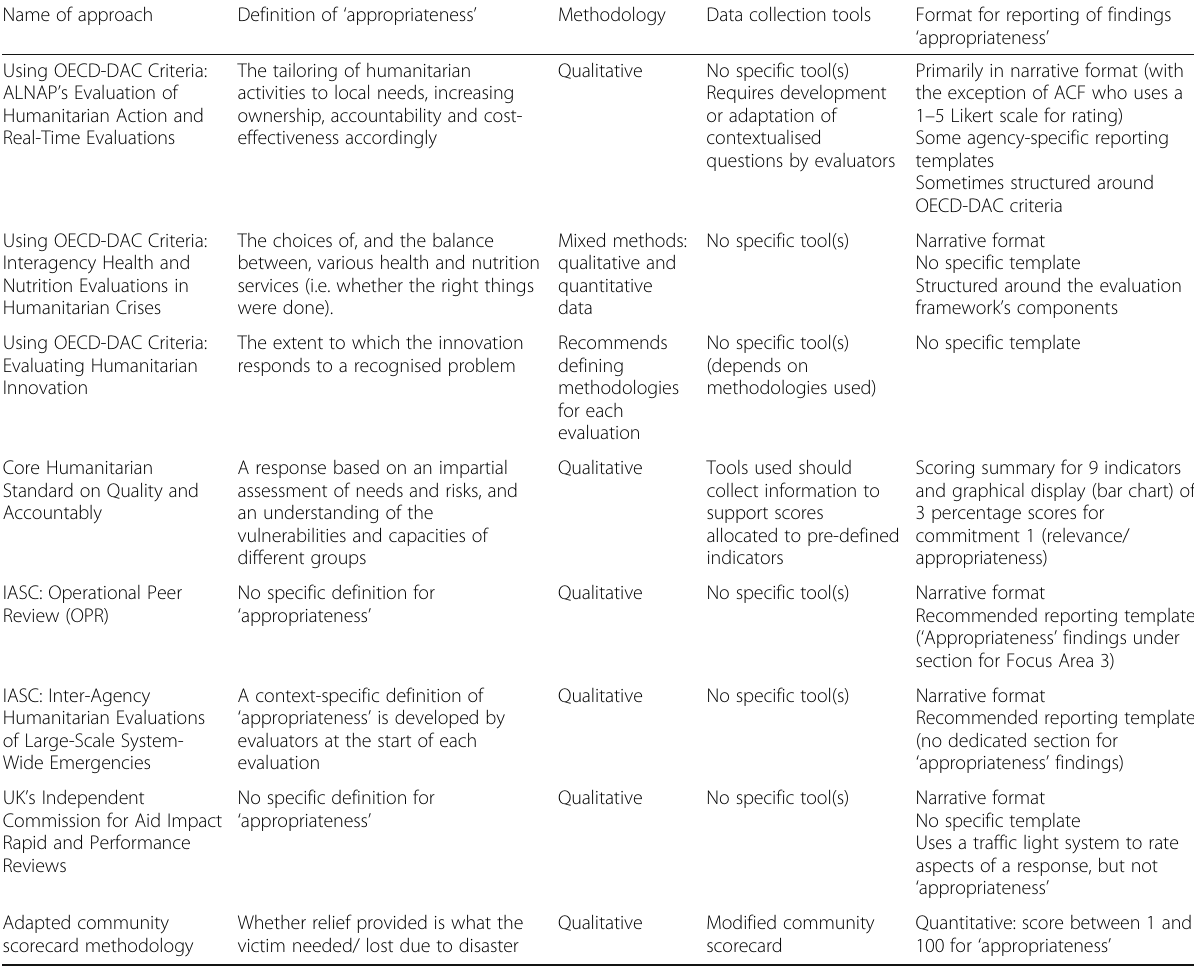
Table 1 Main features of approaches measuring the appropriateness of humanitarian